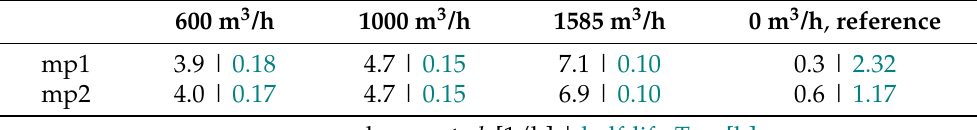
Table 3. Test aerosol particle concentration decay rates and half-lives for config. II for different volume flow